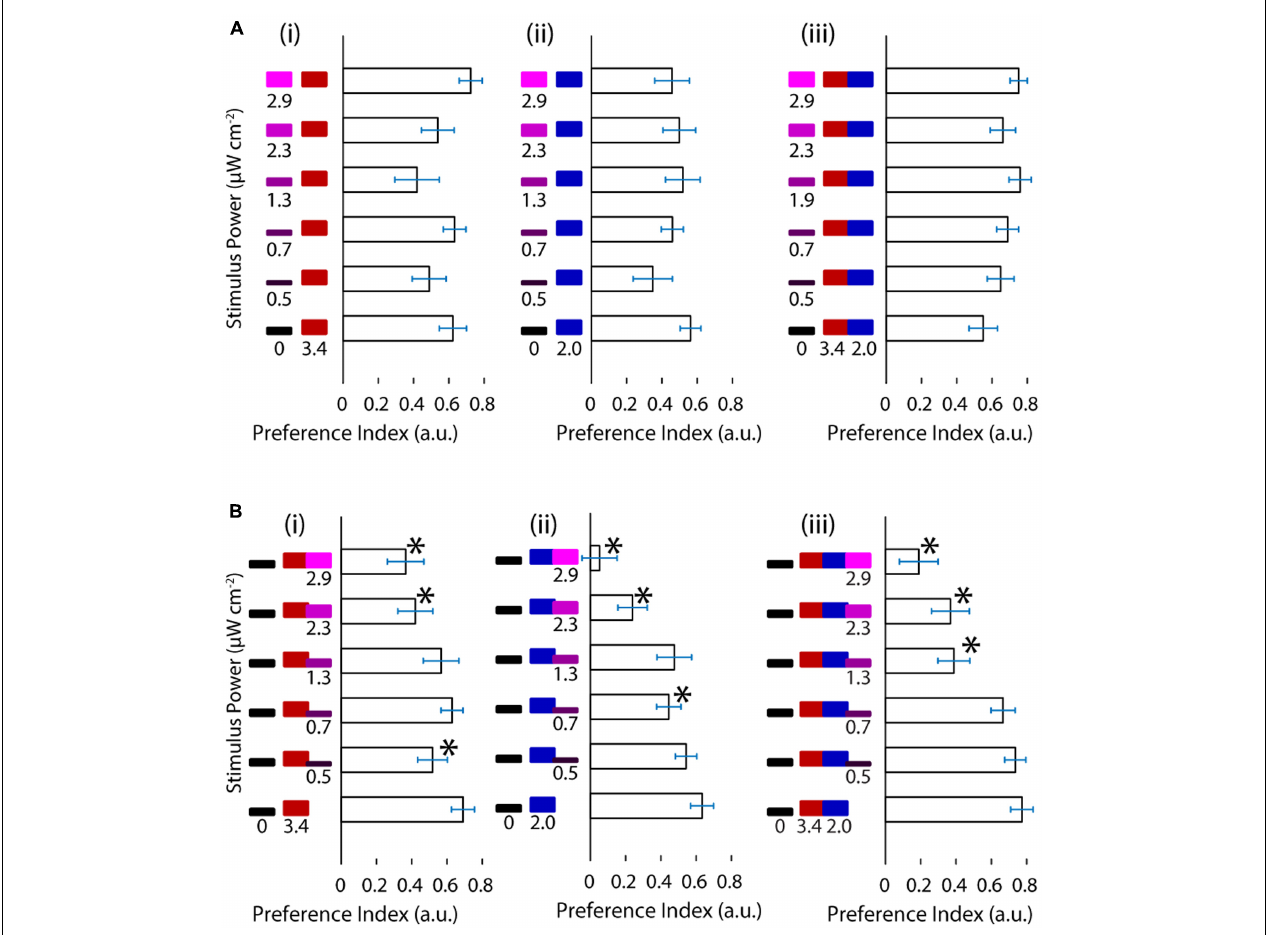
FIGURE 2 | Ultraviolet light is avoided in a manner indistinguishable from darkness and it competes with phototaxis. (A) Preference shown by the larvae for varying levels of UV stimuli vs. red, blue or both red and blue stimuli. (B) Preference of the larvae for darkness vs. red, blue or red and blue stimuli with increasing levels of the UV stimulus. (bars are mean ± SEM, N = 21 for the A panels, N = 20 for the B panels, both with fish from several clutches. Stars represent a p -value < 0.05 in a paired bootstrap test comparing the lowest power value to the